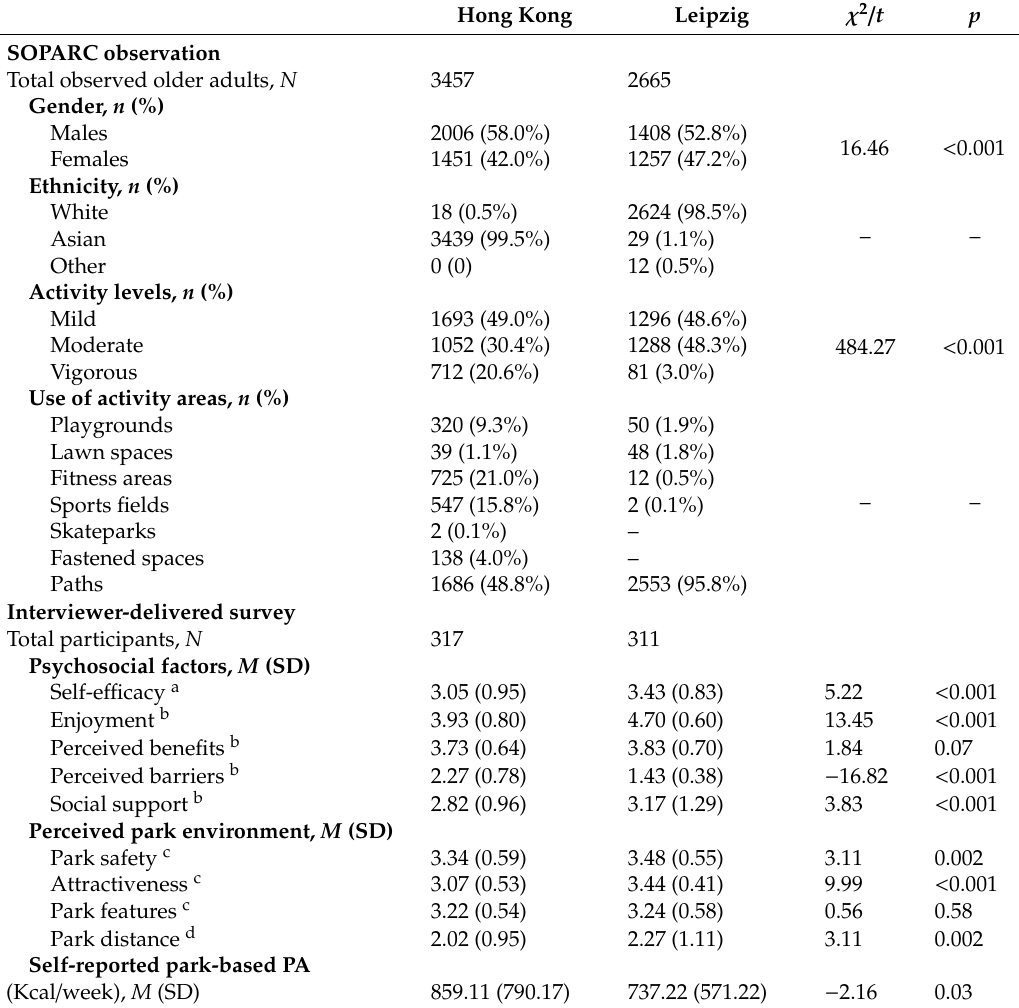
Table 1. Descriptive statistics for the observed and survey sample characteristics by city. Hong Kong Leipzig χ 2 /